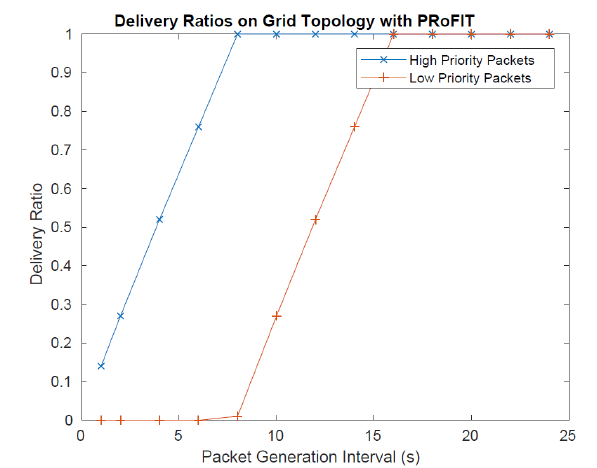
Figure 10. Delivery Ratios on Grid Topology without PRoFIT